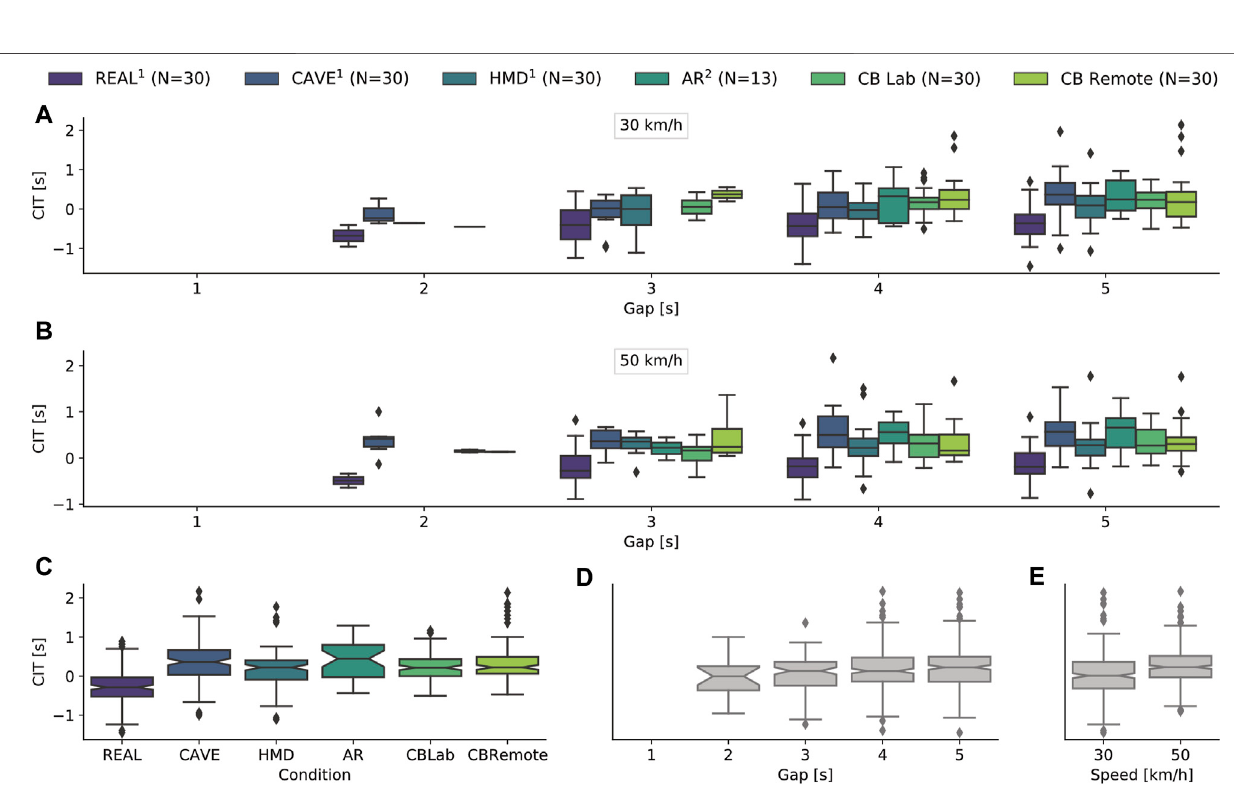
Frontiers in Virtual Reality |